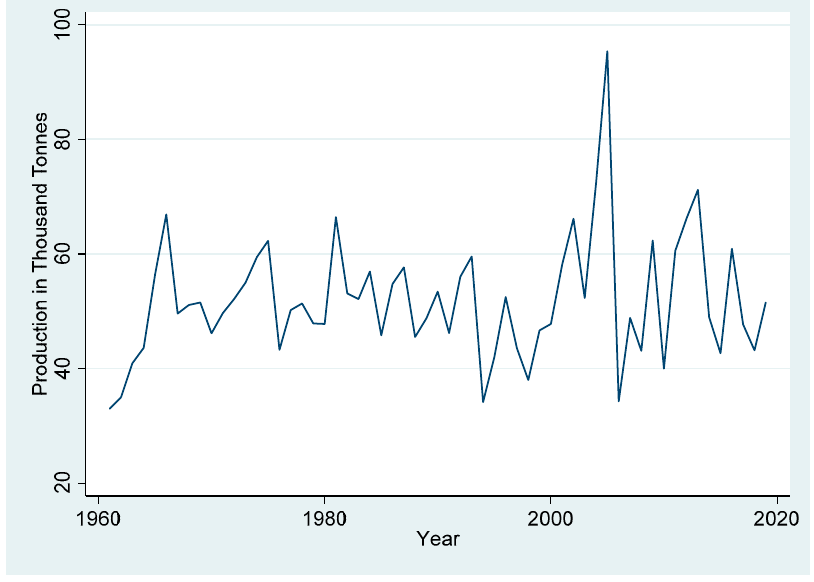
Figure 2. Coffee production in Tanzania. Source : computed from FAOSTAT 2020 data.